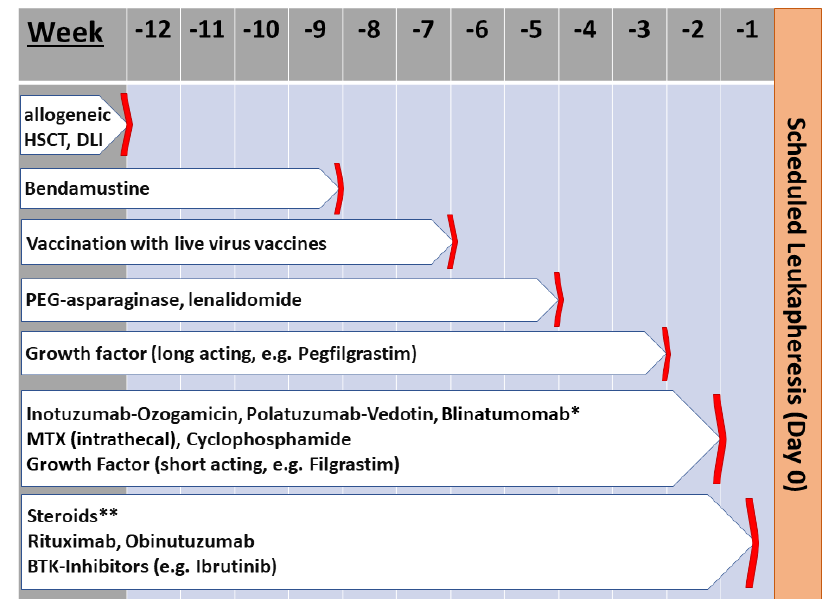
Figure 7. Stopping rules for ongoing therapies prior to apheresis (HD-CAR-1). Guidelines established for the HD-CAR-1 study at the University Hospital Heidelberg. * First cycle application only. For additional cycles 10–14 days are recommended. ** Low-to-moderate steroid doses only. BTK: bruton kinase, DLI: donor lymphocyte infusion, HSCT: hematopoietic stem cell transplantation, MTX: methotrexate, PEG: pegulated.